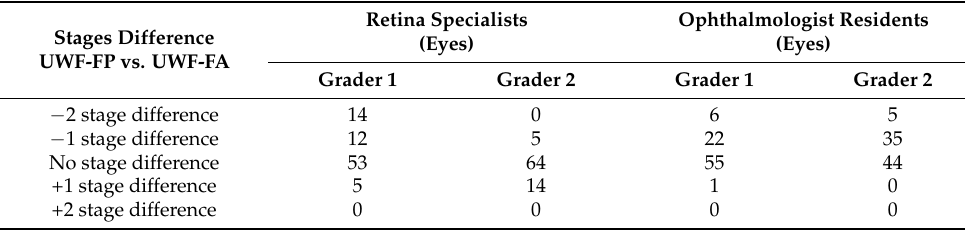
Table 2. Differences in Goldberg staging across UWF-FP and UWF-FA.